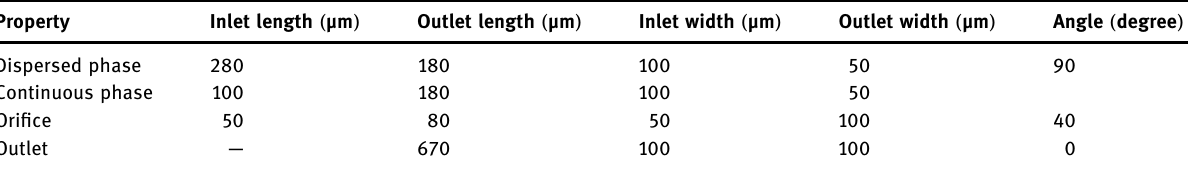
Table 1: Detailed dimensions of MFFD Property